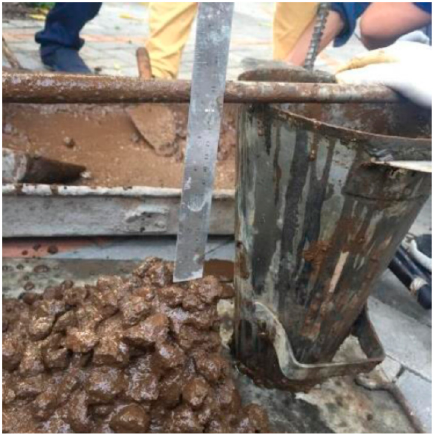
Figure 2. Slump test of the geopolymer concrete mix.